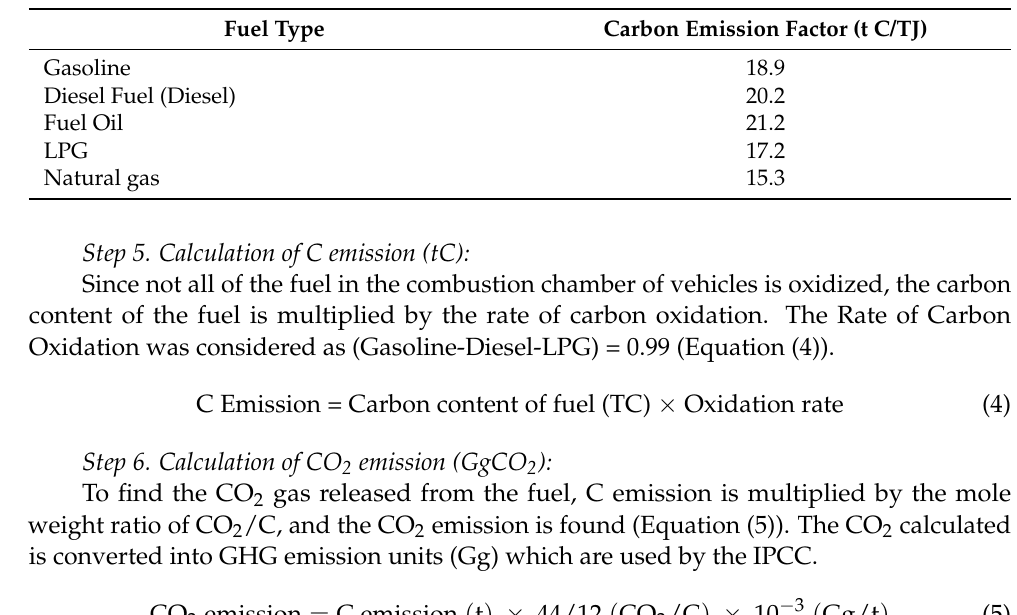
Table 3. The fuel carbon emission factors